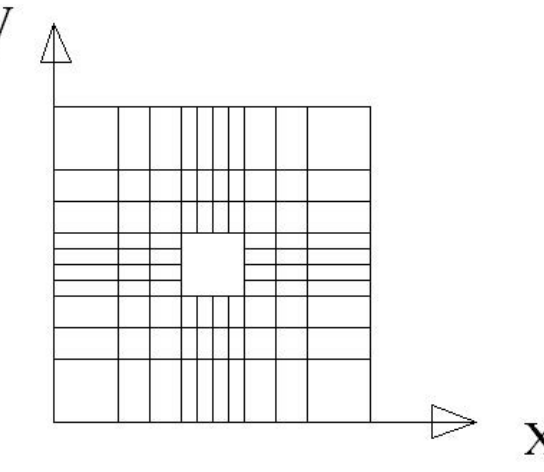
Figure 3: Typical 10 × 10 non-uniform mesh arrangements drawn